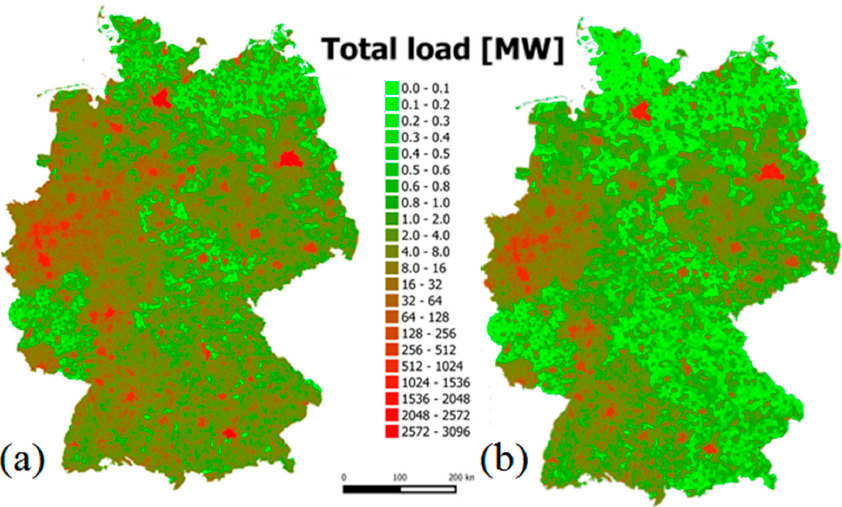
Figure 4. Electrical load in Germany in 2013 according to data from ENTSO-E [26]; ( a ) highest